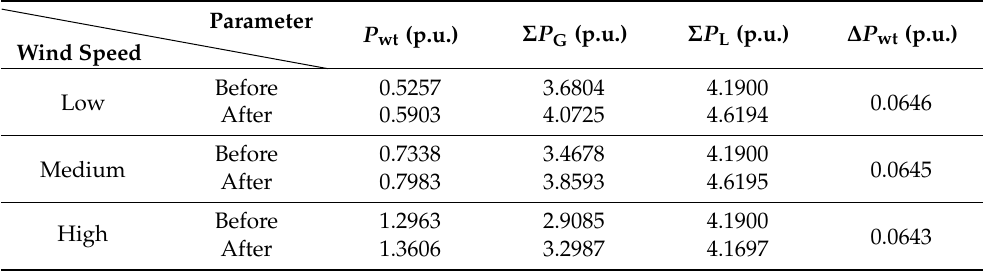
Table 2. Steady state power flows under different wind speeds before and after load disturbance.